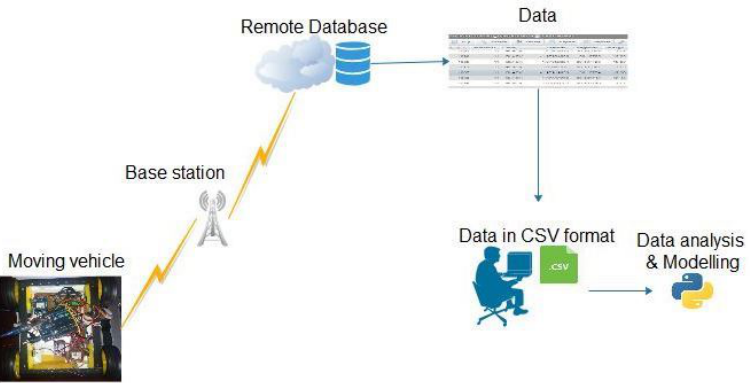
Figure 7. Sample of captured data appealing in the